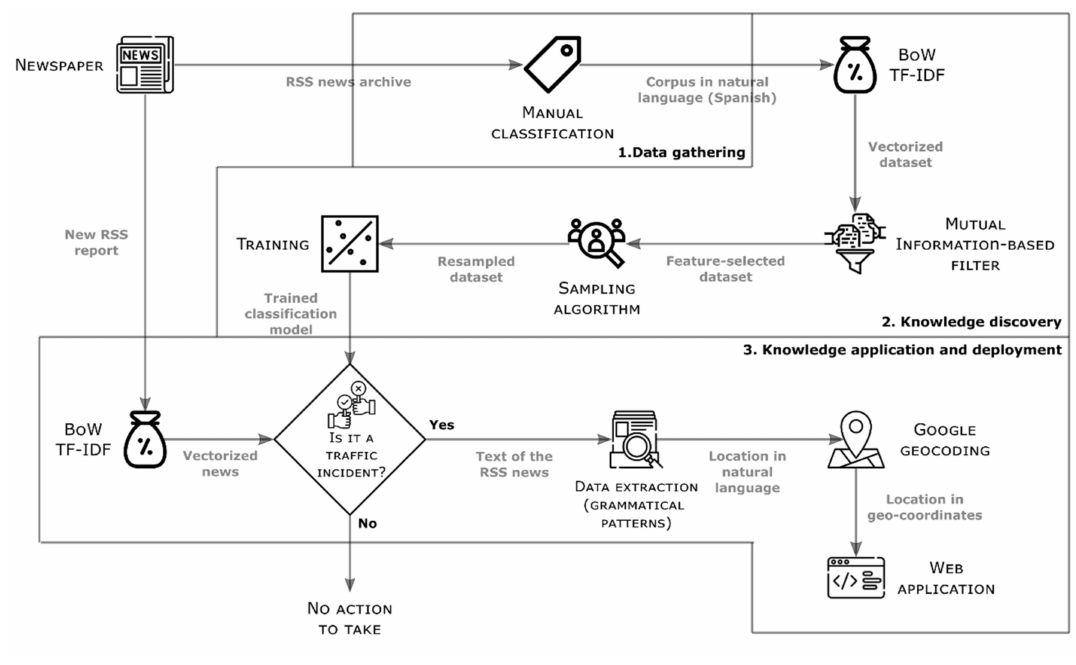
Figure 2. Design of the whole system for news classification and information